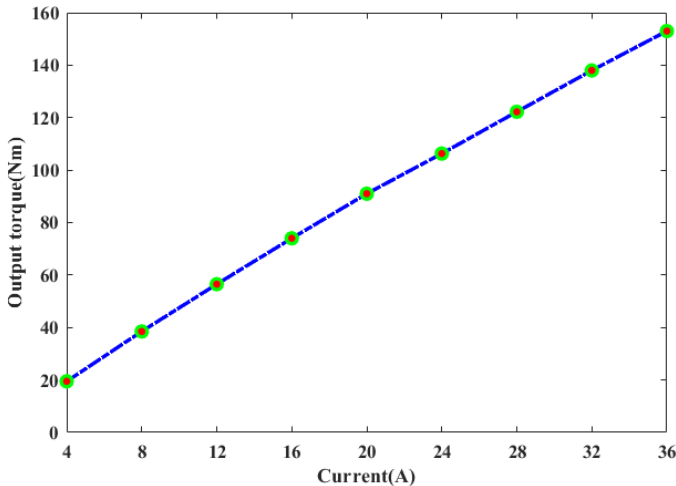
Figure 17. Influence of current on torque.